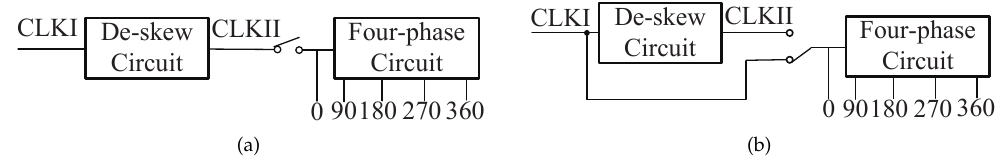
Figure 8. The configuration of the de-skew circuit and four-phase circuit. ( a ) Serial-cascade configu- ration; ( b ) parallel-cascade